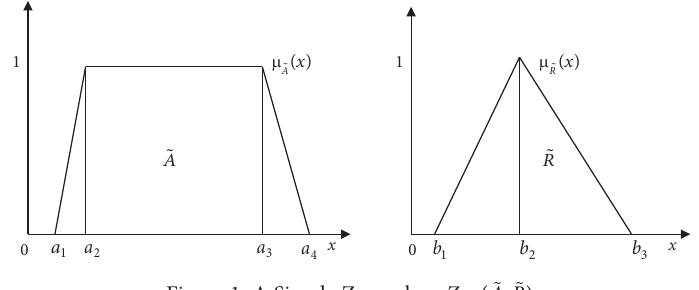
Figure 1. A Simple Z-number ( , ) Z A R = 